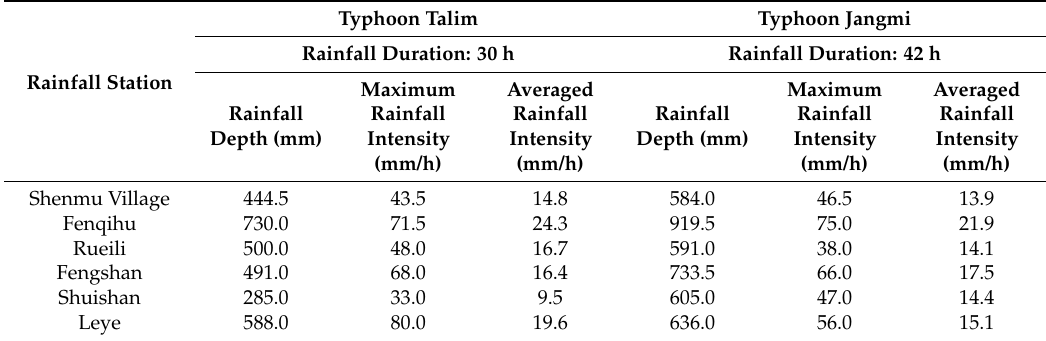
Table 1. Rainfall Characteristics of six rainfall stations during Typhoon Talim and Typhoon